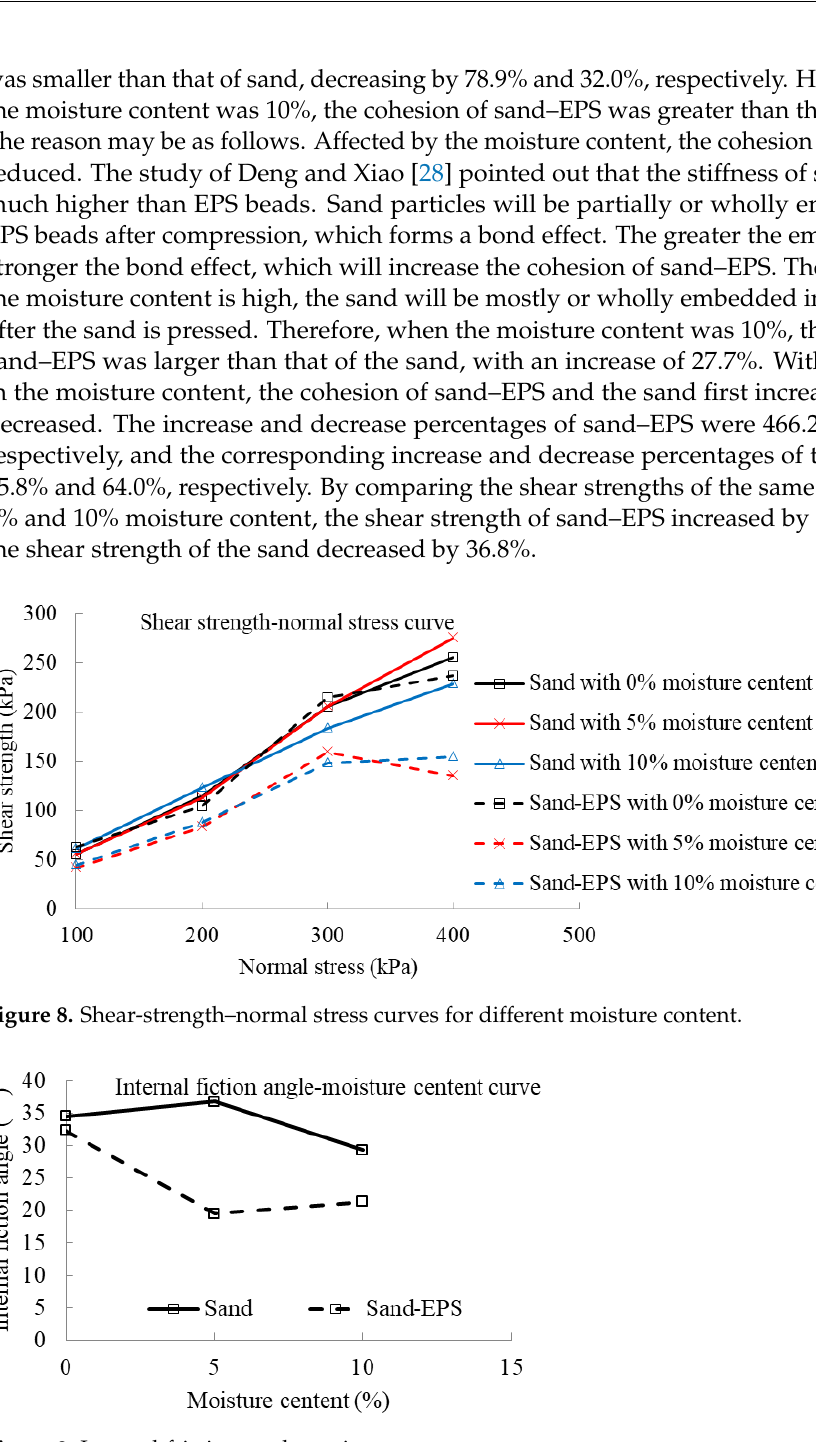
Figure 9. Internal-friction-angle–moisture